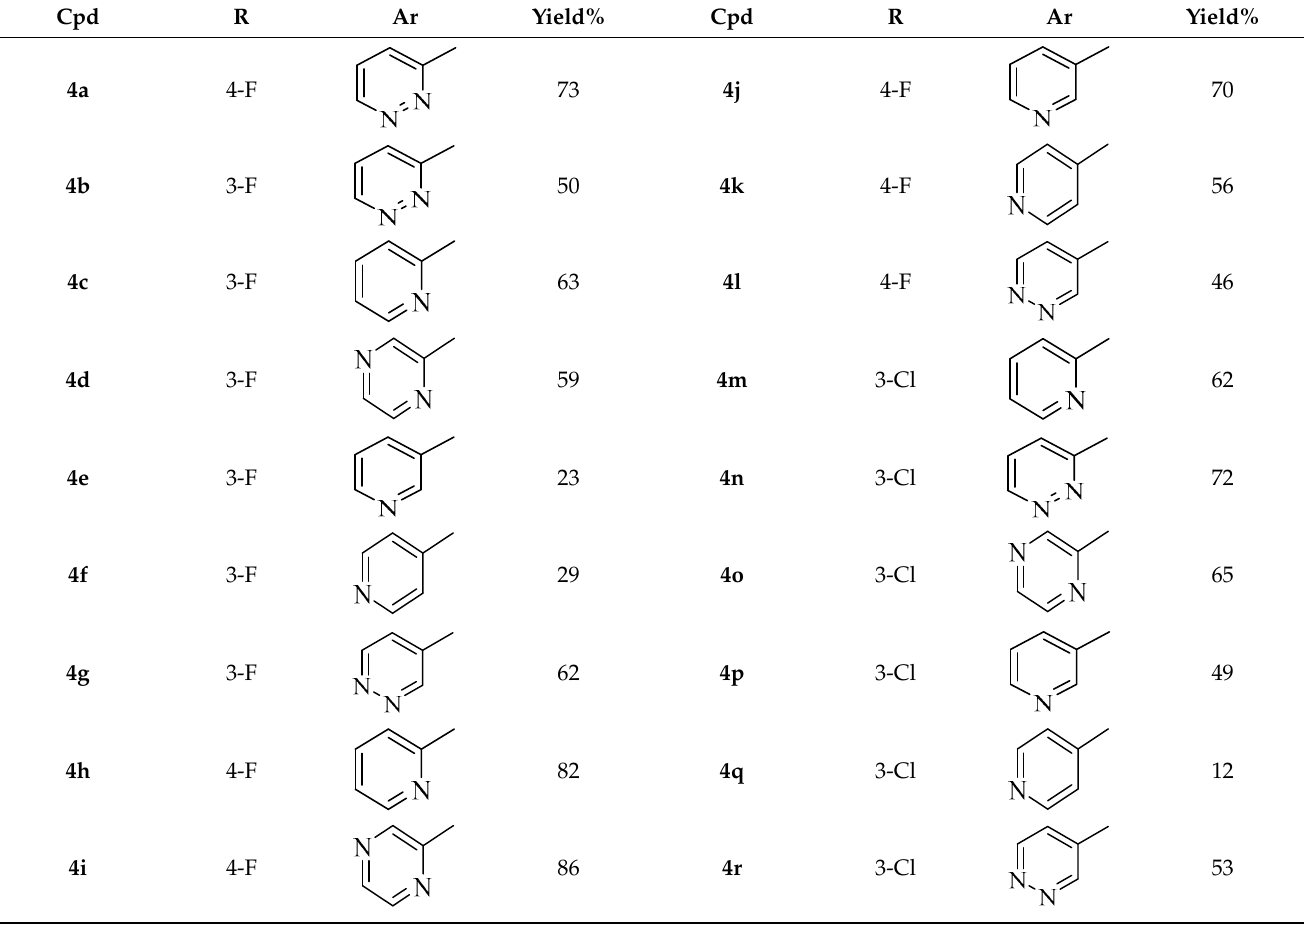
Table 1. Key Structure of the final target compounds 4a ‒ r.